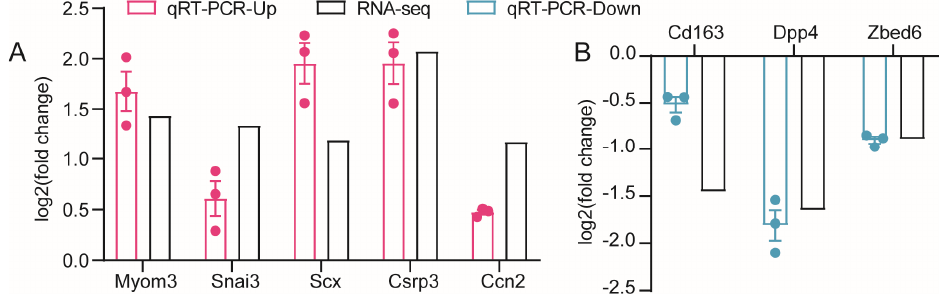
Figure 8. The verification of DEGs profile. ( A – B ) The verification of expression levels of 5 up-regu- lated DEGs and 3 downregulated DEGs on the basis of qRT-PCR and RNA-seq data. Log2 (fold change) > 0 or < 0 indicates the DEG was upregulated or downregulated in Zbed6 +/ − group compared with WT group. Points in different colors represent actual data of